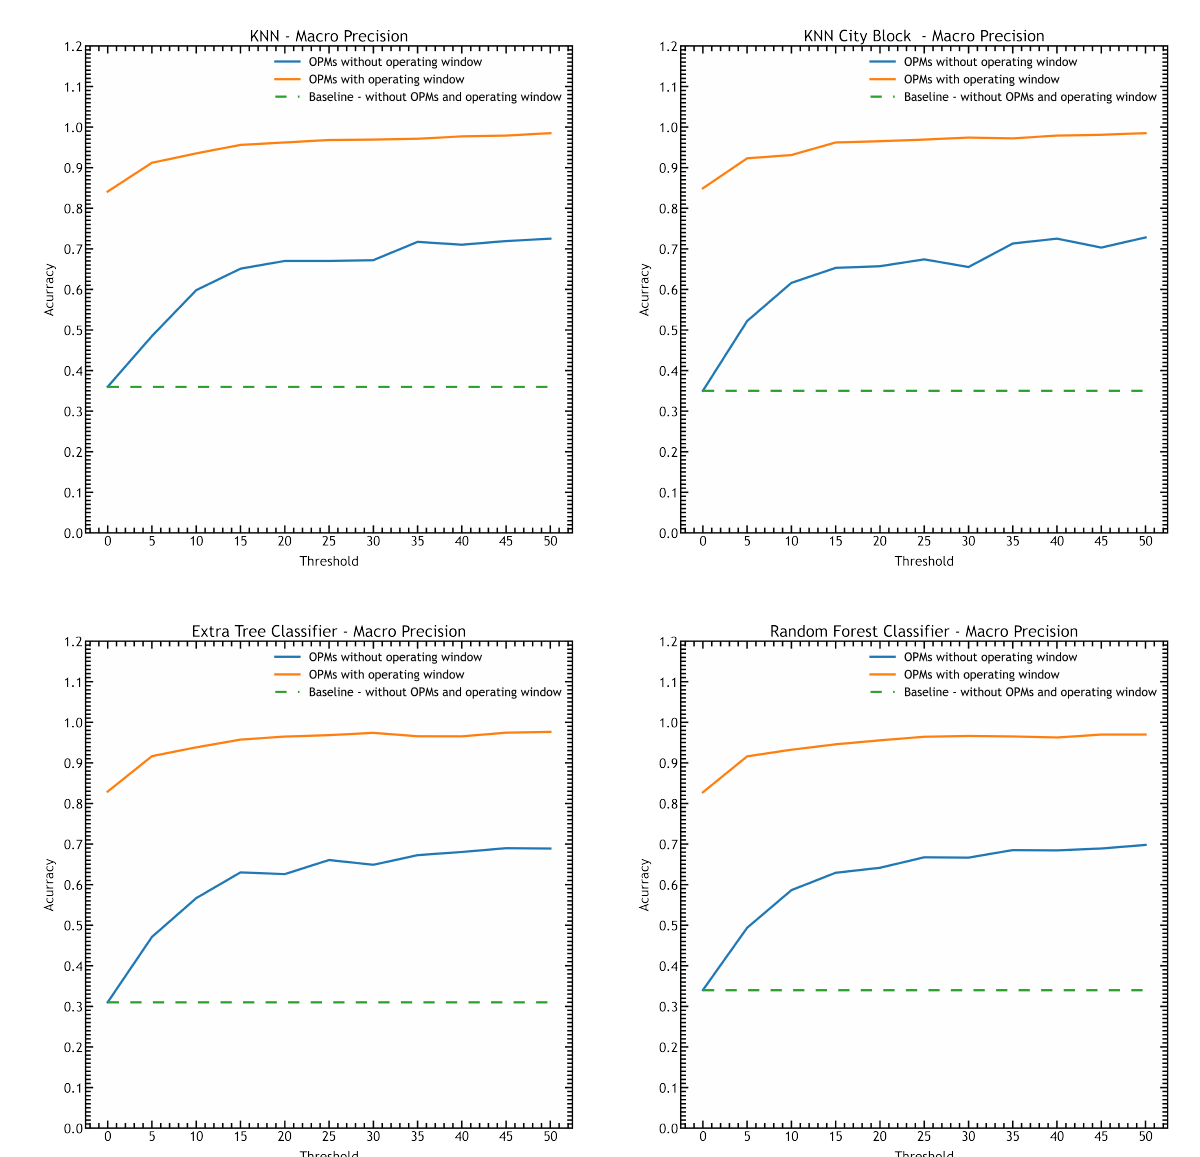
Figure 4. Impact of the power profile and thresholding on the macro accuracy of the trained